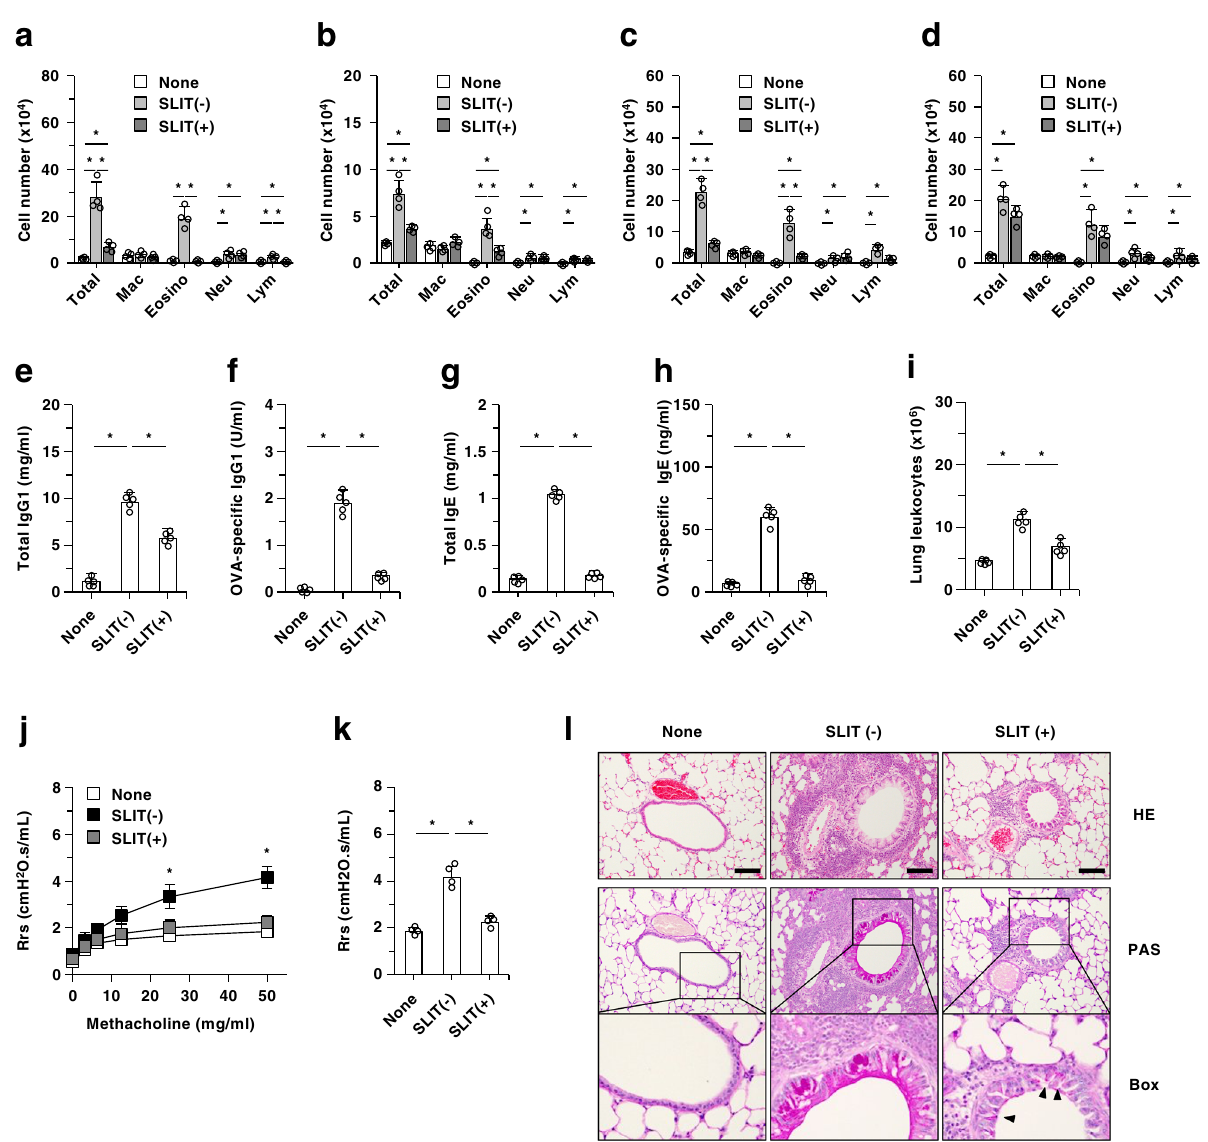
Fig. 1 De fi ciency of cDCs dampens the protective effect of SLIT on T H 2-mediated allergic airway in fl ammation. WT mice and CD11c-DTR/EGFP mice that had been treated with PBS or DT were sublingually administrated with PBS or OVA protein, and then systemically immunized with or without OVA protein at 7 and 14 days after SLIT. Subsequently, mice were intranasally sensitized with or without OVA protein at 10, 11, and 12 days after the last immunization, and BALF, serum and lung tissue were obtained at 13 days after the last sensitization. a – d Absolute cell numbers of BALF cells obtained from Balb/c WT mice a , B6 WT mice b , and CD11c-DTR/EGFP mice that had been treated with PBS c or DT d . Mac , macrophages; Eosino , eosinophils; Neu , neutrophils; Lym , lymphocyte. e – h Serum production of total IgG 1 e , OVA-speci fi c-IgG 1 f , total IgE g , and OVA-speci fi c IgE h in Balb/c WT mice. i Absolute cell numbers of lung leukocyte obtained from Balb/c WT mice. j , k Respiratory airway function was analyzed for changes in resistance of the respiratory system (Rrs) in response to increasing doses ( j 3.125 – 50 mg/ml) or the indicated dose ( k 50 mg/ml) of inhaled methacholine in Balb/c WT mice. l Hematoxylin and eosin (HE) and periodic acid – Schiff (PAS) sections obtained from the lung in Balb/c WT mice at low-magni fi cation (×20) and higher magni fi cation (×40). Bars indicate 100 μ m. Arrow indicates mucus deposition. Data are obtained from fi ve individual samples in a single experiment. * P < 0.05 compared with normal mice (none) or among groups. All data are representative of at least three independent